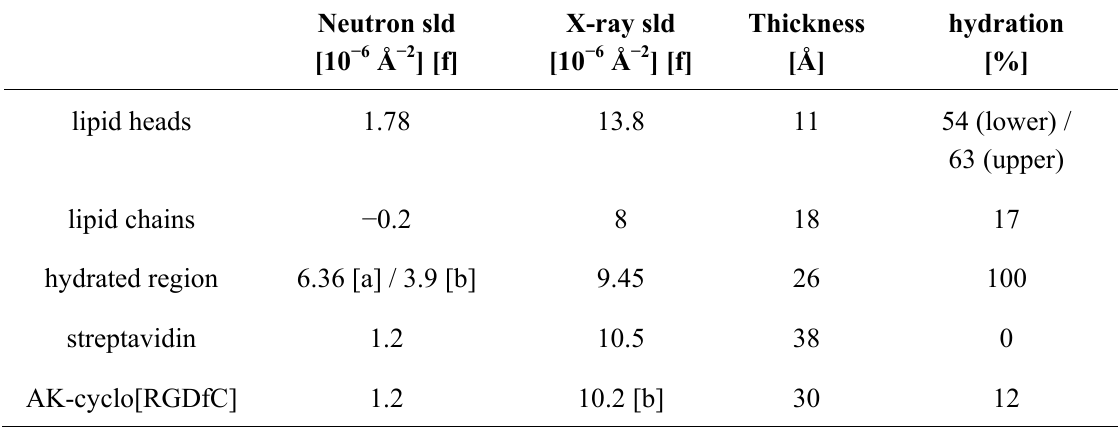
Table 1. Parameters obtained from neutron and X-ray reflectometry data. The values describe the slab model of the sld and hydration profiles depicted in Figure